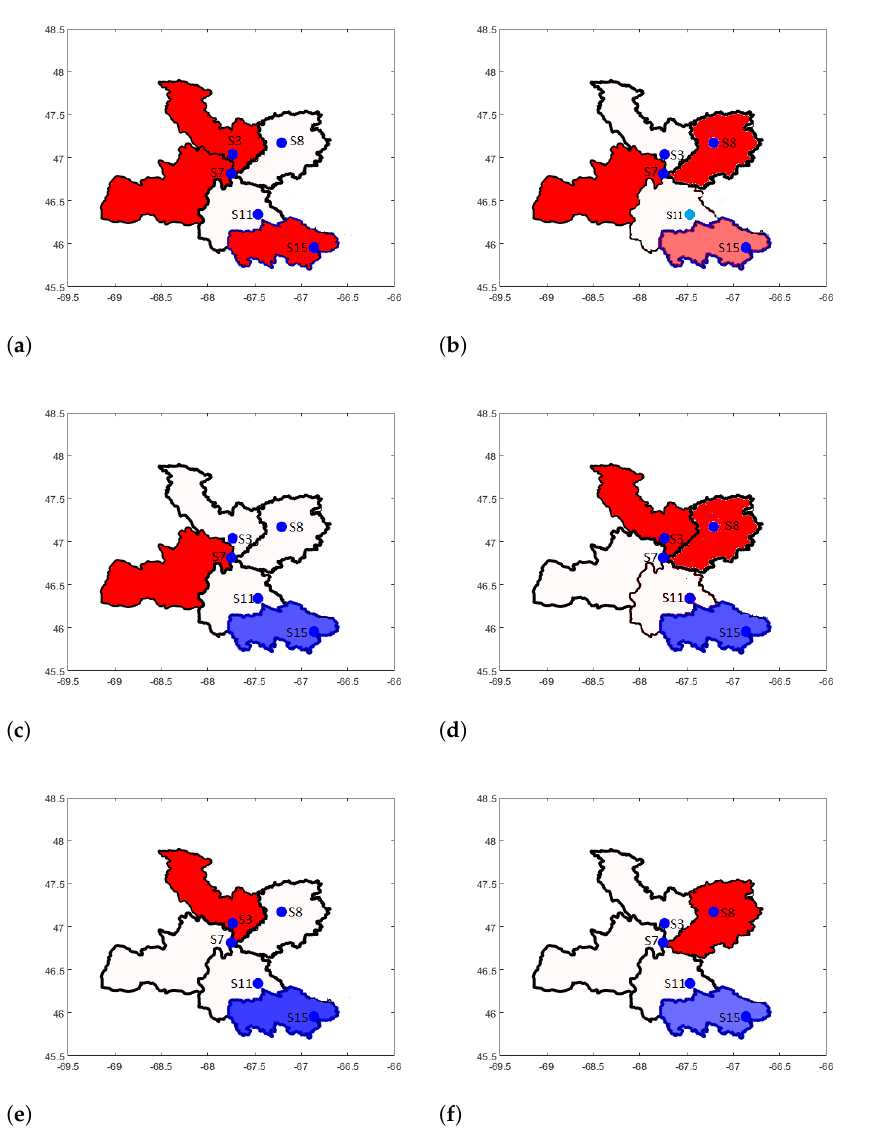
Figure 8. Illustration of the obtained scenarios with respect to downstream conditional quantiles. The red color means values are set to Q 100 as in Table 5. White means values are set to Q 2 . For station 15, blue means the conditional quantile S15 Q 100 is less than the marginal index, it is pink when they are almost equal and red when S15 Q 100 is much greater than the marginal index. (a–f) : scenarios 5, 8, 2, 6, 1, and 3